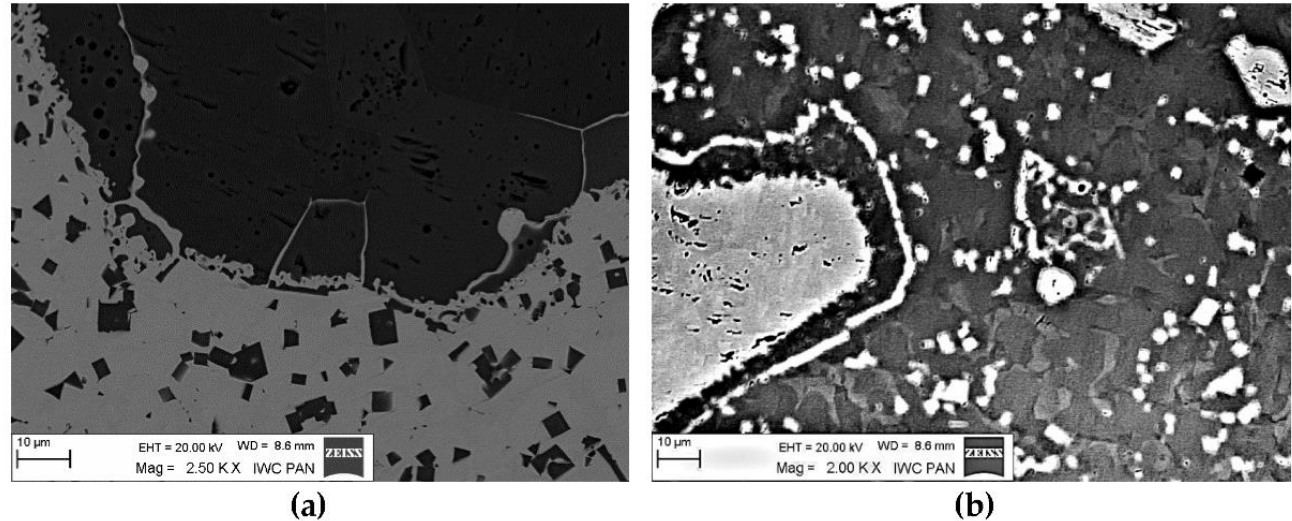
Figure 10. Disintegration of the carbide particle outer layer in the liquid matrix: ( a ) TiC and ( b ) ZrC.